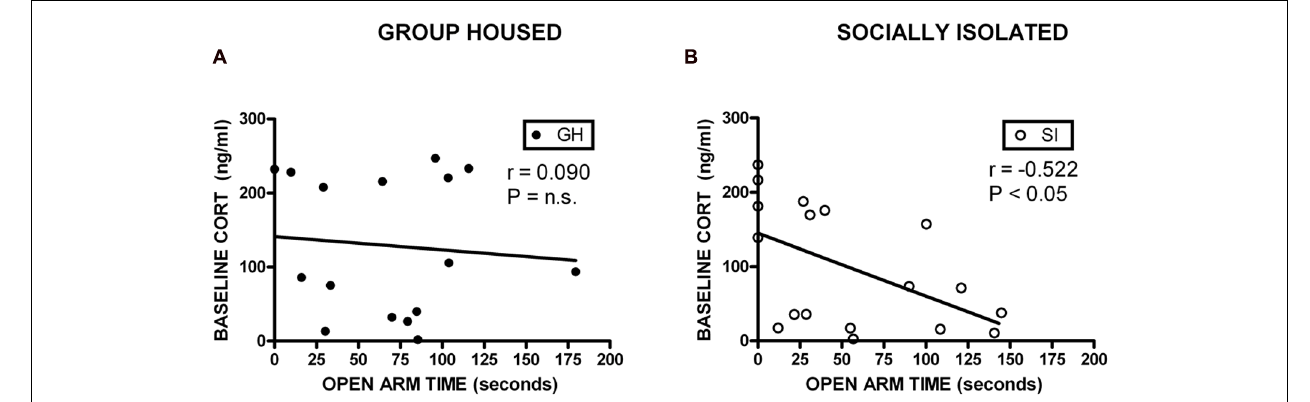
FIGURE 6 | Correlations between corticosterone (CORT) and anxiety-like behavior. For SI rats, there was a significant negative correlation between baseline CORT and open arm time (B) , indicating that higher levels of